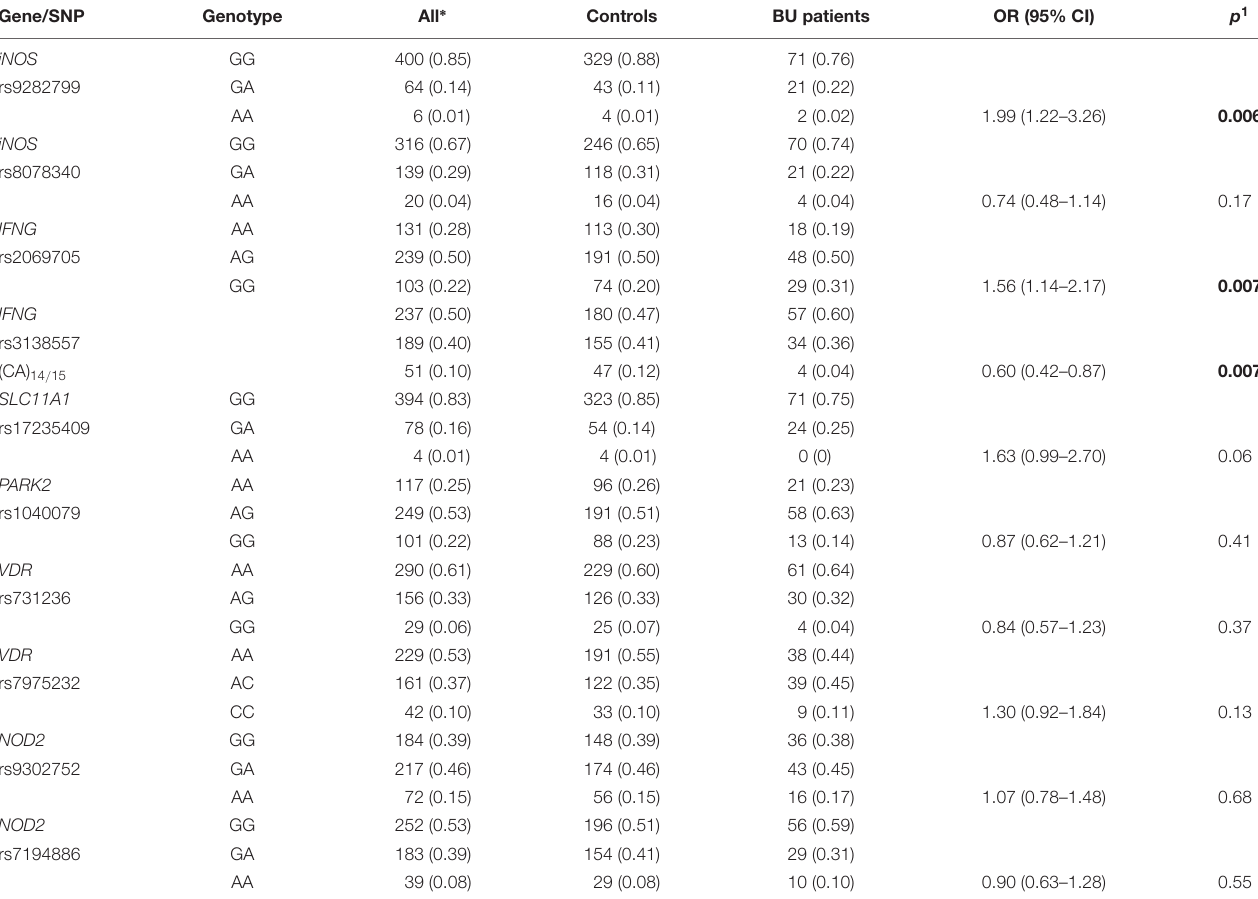
TABLE 2 | Independent genetic factors associated with BU susceptibility among candidate genes. Gene/SNP Genotype BU